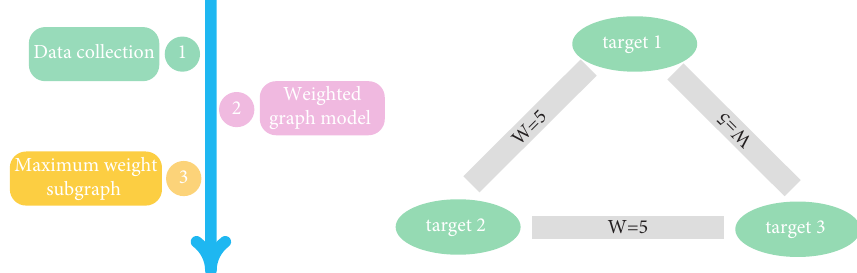
Figure 4: Following chart of the